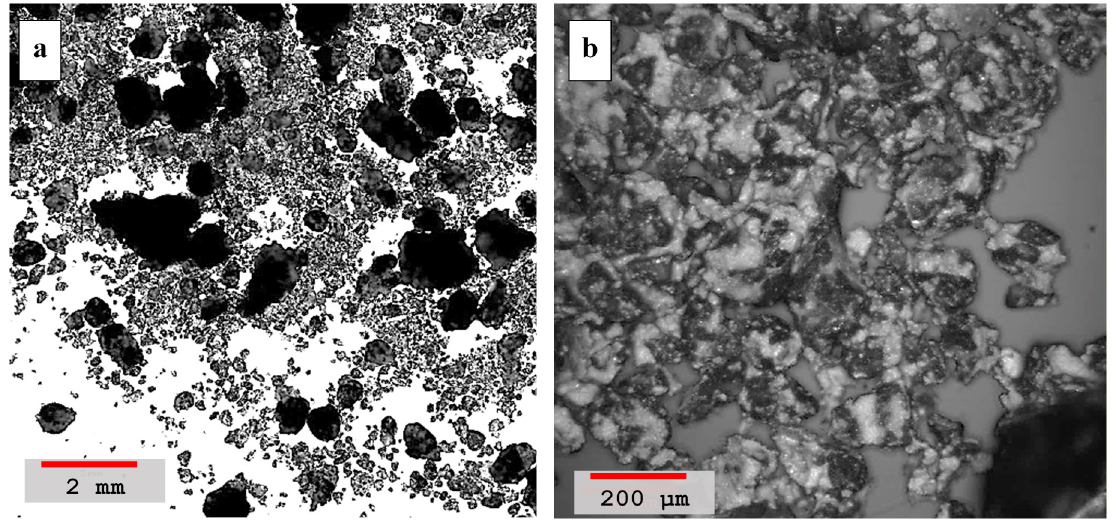
Figure 8. ( a ) Laser scanning microscopy images of hydrated and blended mortar containing the lime-to-ash ratio ≈ 0.67, sample #d in the Table 4, recorded at a lower 5 × magnification image (red color scale-bar shows ≈ 2 mm length). ( b ) Morphological image of the sample at a higher magnification of 50 × with scale-bar showing ≈ 200 µ m length.